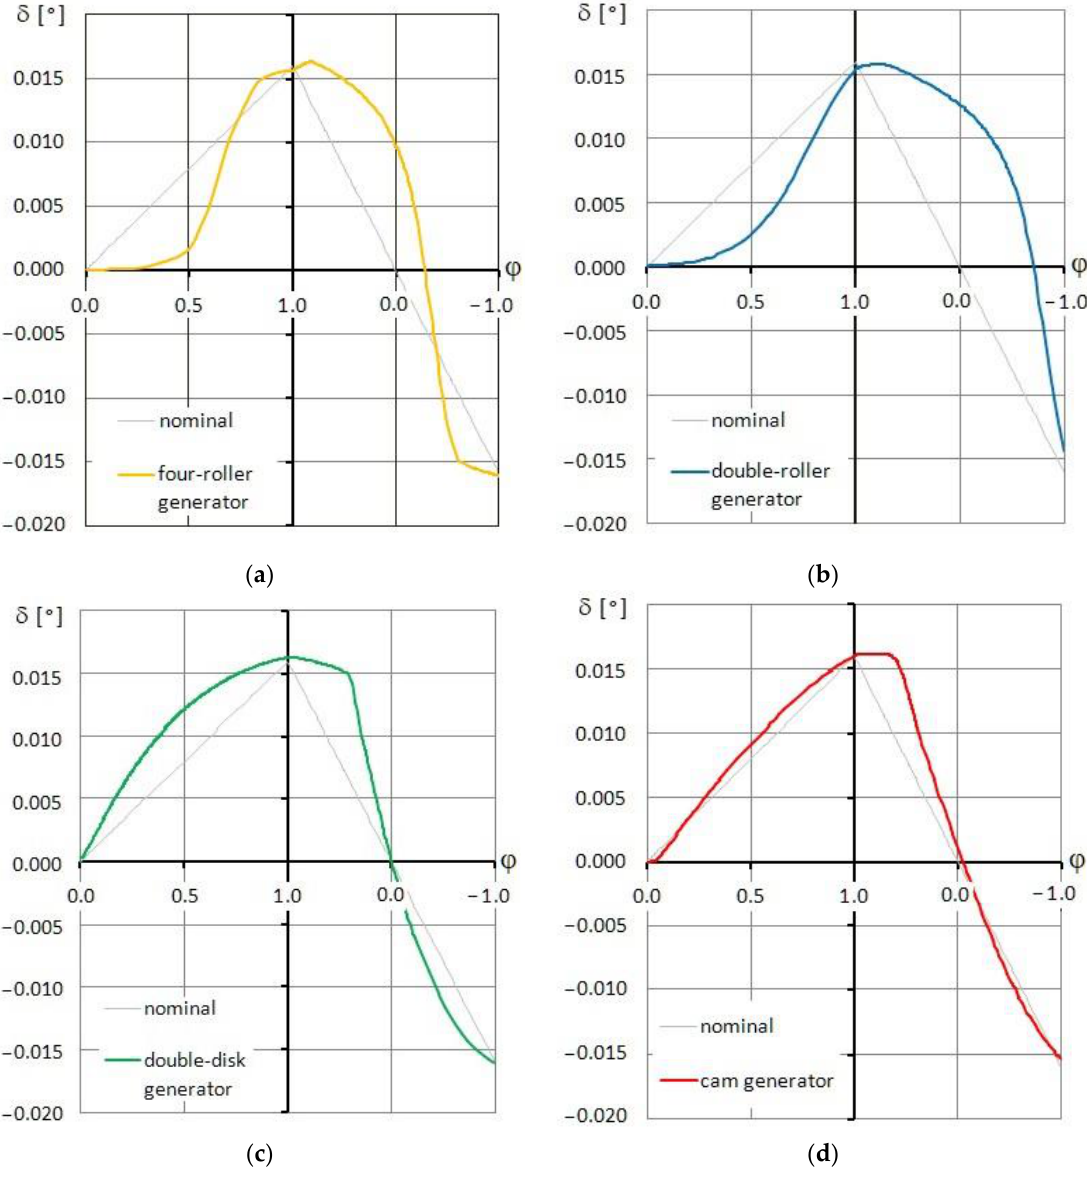
Figure 12. The angle of the rotation of circular spline as the result of generator work: ( a ) two-roller; ( b ) four-roller; ( c ) double-disc; ( d ) cam.